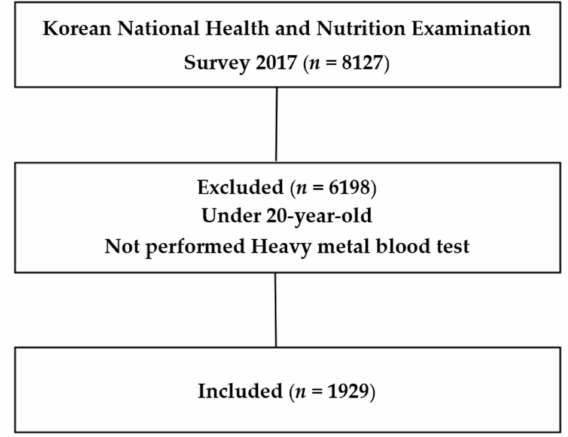
Figure 1. Simplified flow chart of study subject